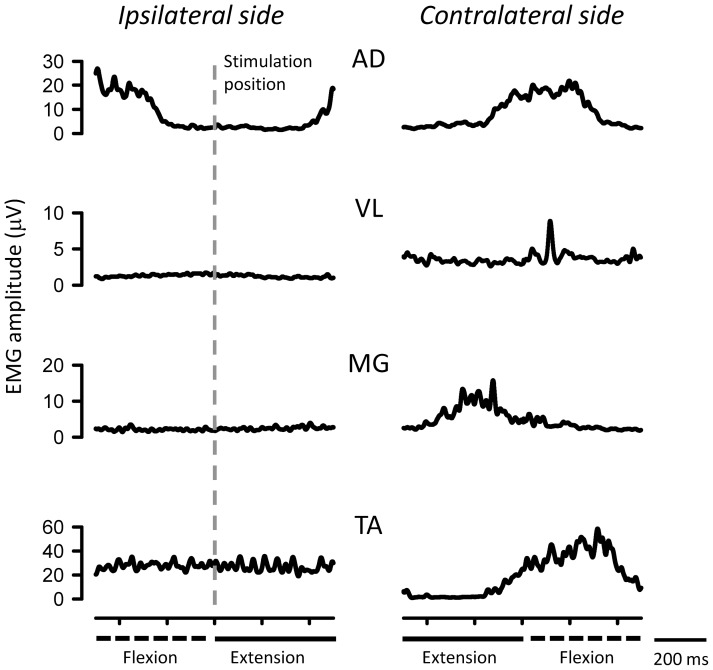
Typical recordings of EMG activities in AD, VL, MG and TA muscles during ARM&LEG movement for a single subject.Gray vertical line: stimulation position of ipsilataral side. Dashed lines: flexion phase of movement. Thick lines: extension phase of movement.